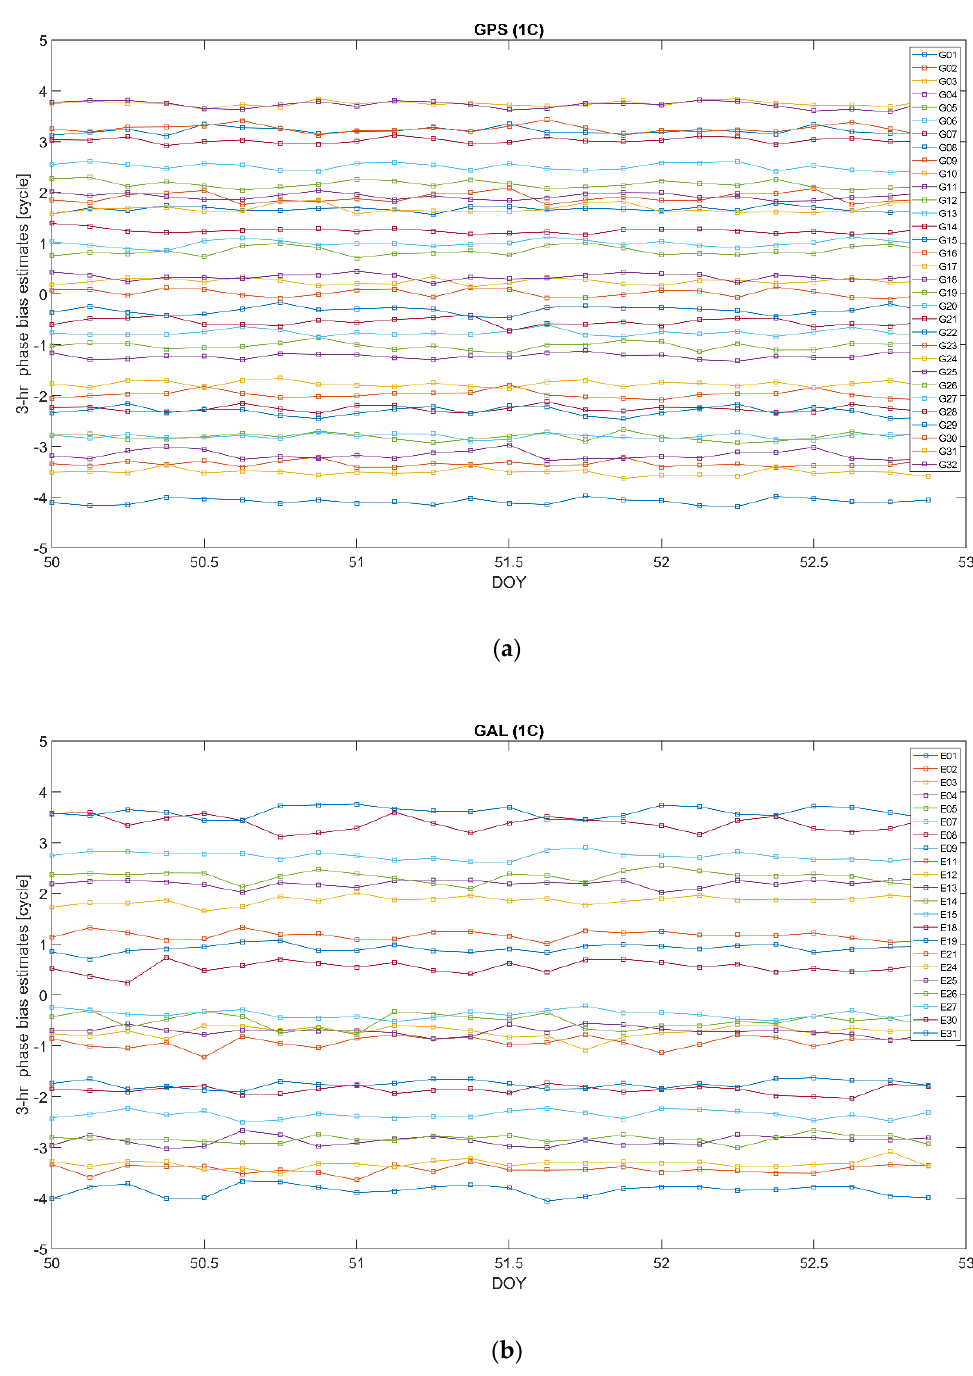
Figure 9. Sub − daily (3 h − long) bias ϐ MWCs estimates over a 3 − day time interval 2020/50 – 2020/52 for GPS L1 ( a ) and GALILEO E1 ( b ). The time series for individual satellites are shifted along the y − axis by PRN − 16 times 0.25. “1C” corresponds to L1 C/A for GPS and E1 pilot channel for GALILEO . We can see that, in general, the bias estimates for both the constellations are noticea- bly stable, similar to their daily counterparts. At the same time, as in the case of the daily estimates, the GALILEO bias estimates reveal a higher variability compared with their GPS counterparts.